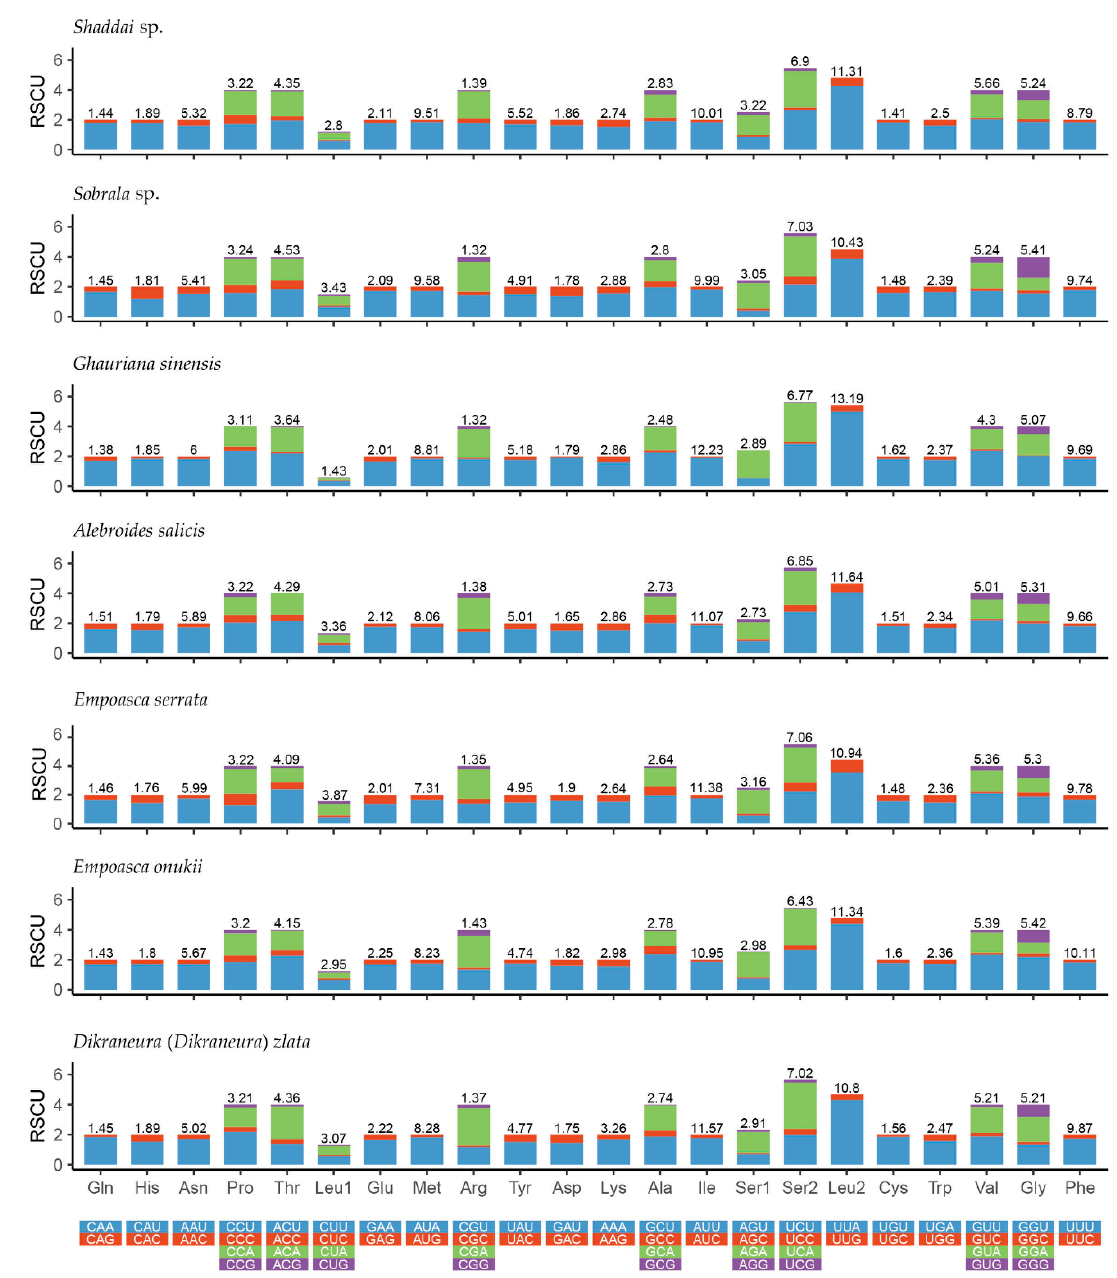
Figure 2. Relative synonymous codon usage (RSCU) in the mitogenomes of Shaddai sp., Sobrala sp., Alebroides salicis , Empoasca serrata , Empoasca onukii and Dikraneura ( D. ) zlata.